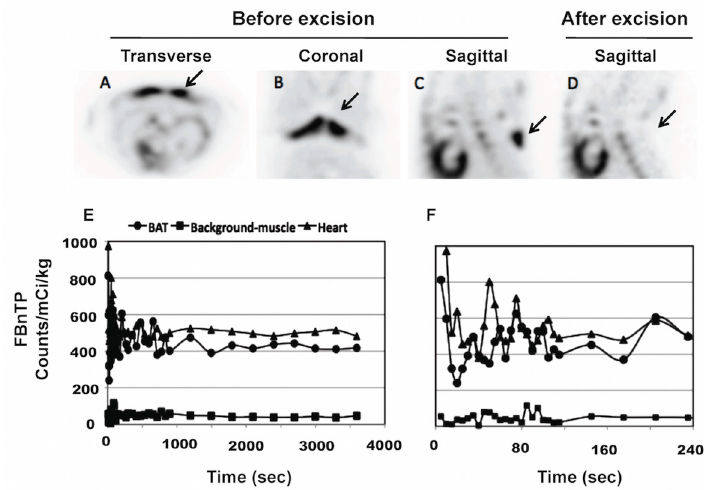
Fig 2. 18 F-FBnTP Uptake Kinetics and Selectivity to BAT at Rest. 18 F-FBnTP PET images acquired in same animal before (A — C) and after surgical excision of BAT (D), and related time-activity curves (E — F). Note the lack of uptake in the interscapular area after BAT excision (D). Images in (A to C) and (D) represent PET scans acquired in the same animal at an interval of 12 min. Chart in (E) represents 18 F-FBnTP time activity curve generated from the same animal in (A to C). Chart in (F) is zooming of the first 240 sec in (E). Y- axis in (F) has same unit value and scale as in (E). Note the strong 18 F-FBnTP uptake in BAT, which is similar to that in the heart, and 8 times greater than background activity (E). 18 F-FBnTP reaches plateau concentration in BAT within less than a minute